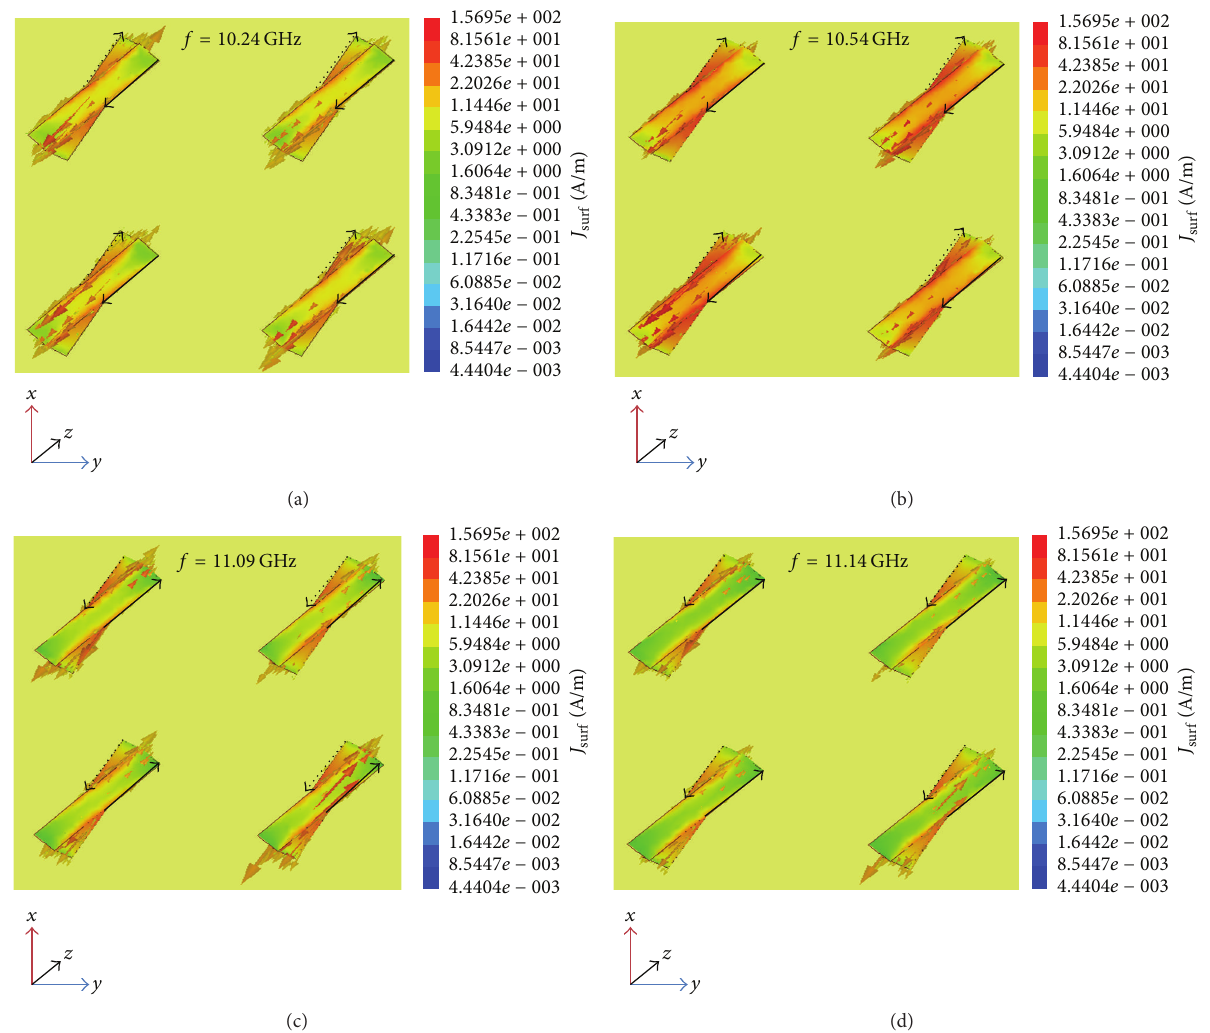
Figure 4: The figure shows the distributions of surface currents on top and bottom strips under the incident field with 𝐸 in the 𝑥 direction propagating along + z direction at (a) 𝑓 = 10.24 GHz, (b) 𝑓 = 10.54 GHz, (c) 𝑓 = 11.09 GHz, and (d) 𝑓 = 11.14 GHz.